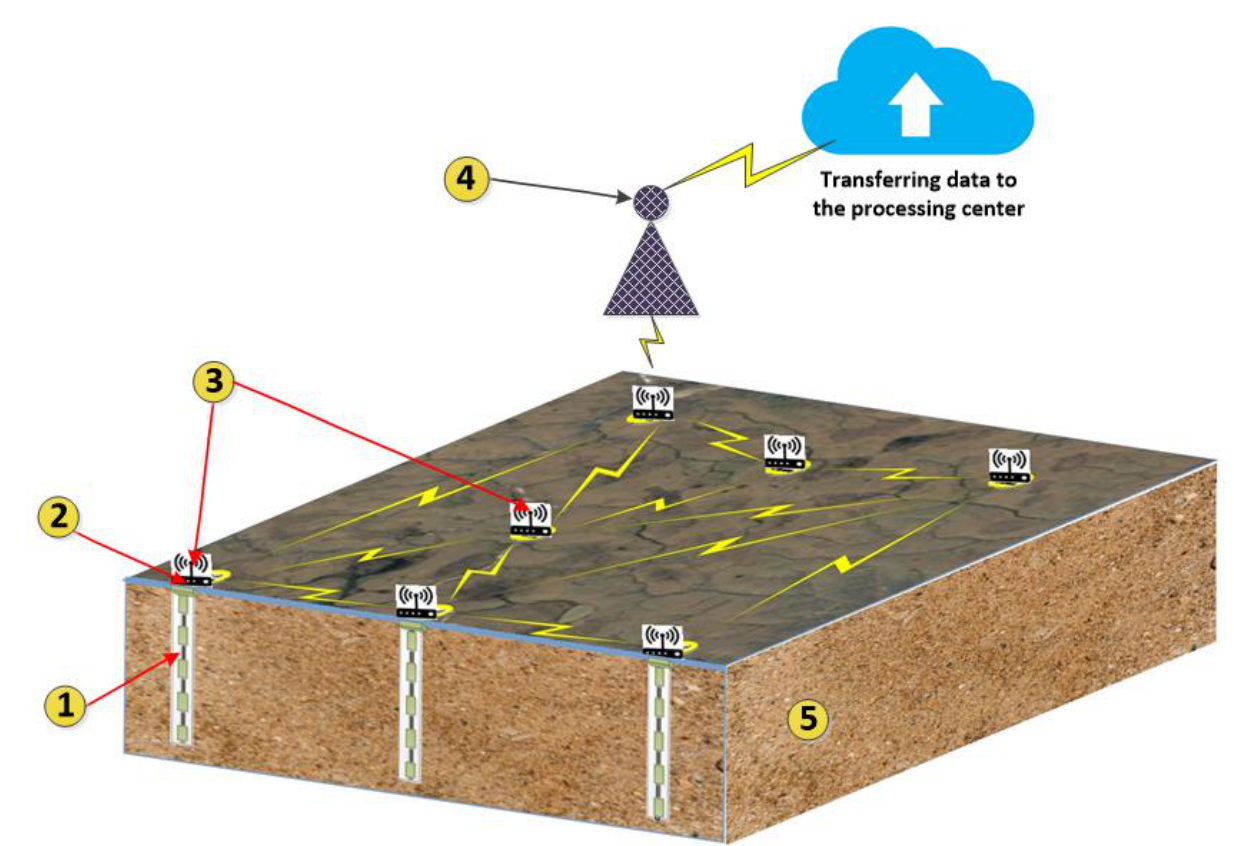
Figure 10. Topology of the network of autonomous multimodal measuring stations, distance between stations (1–15) km. 1—sensors for measurements inside the soil; 2—sensors on the ground surface to measure greenhouse gas emissions; 3—modems of measuring stations; 4—gateway for data transmission to external networks; 5—soil layer under